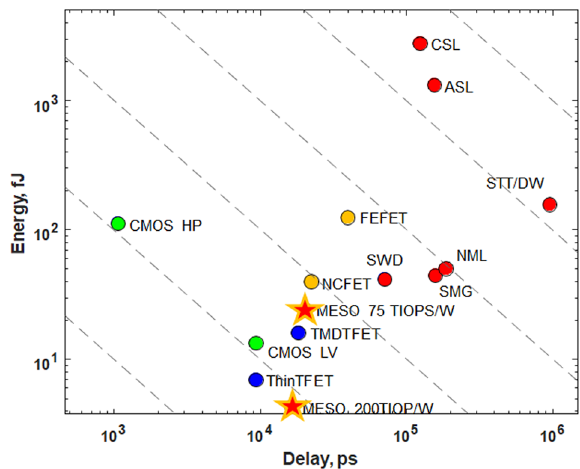
Fig. 3 Benchmarks of performance, switching energy vs. delay in one clock cycle of a 32-bit arithmetic logic unit (ALU). CMOS HP: high-performance transistors from the 2018 process generation (0.73V supply), CMOS